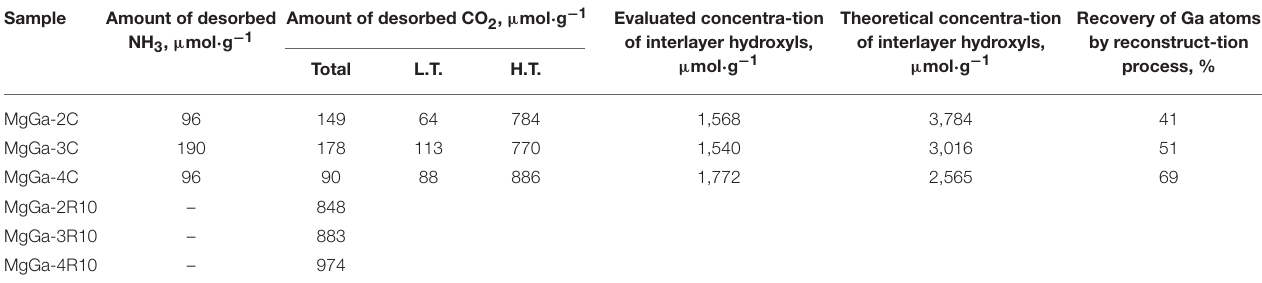
TABLE 3 | Concentration of acid and basic sites in MgGa mixed oxides determined by TPD of adsorbed NH 3 and CO 2 , correspondingly.